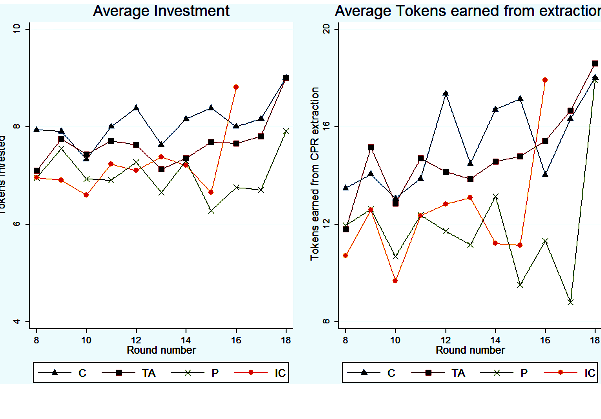
Fig. 7. Development of average provision and appropriation over game rounds depending on institutional